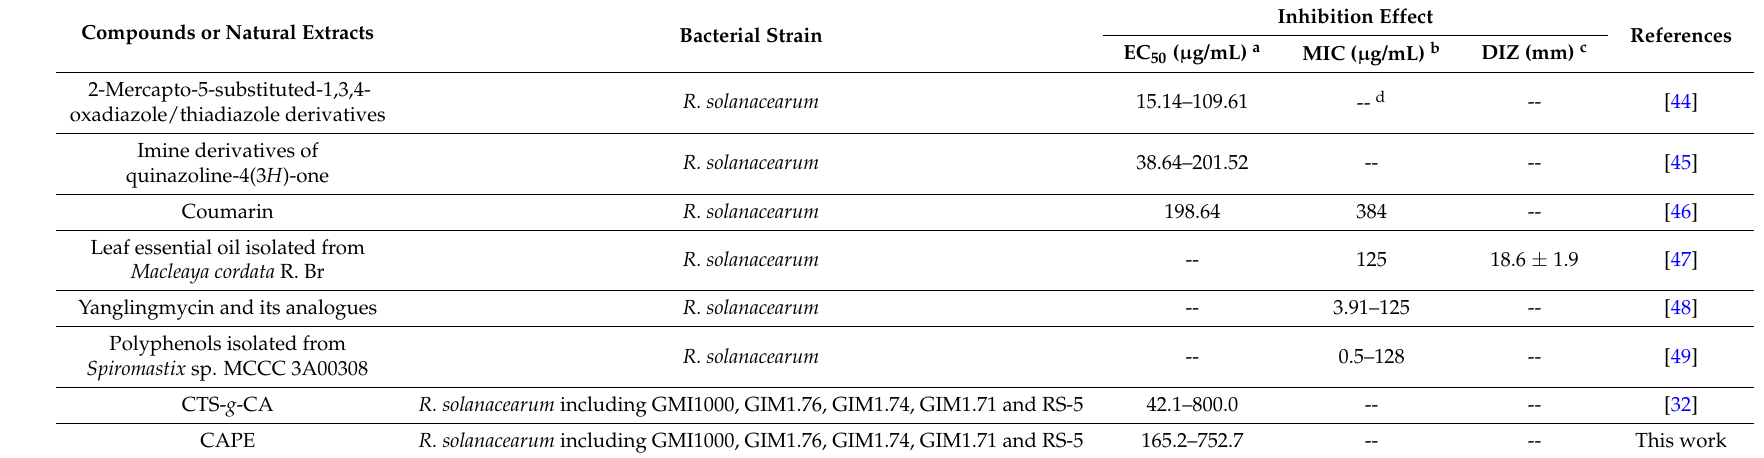
Table 5. Various agents to control bacterial wilt diseases caused by R. solanacearum in the present